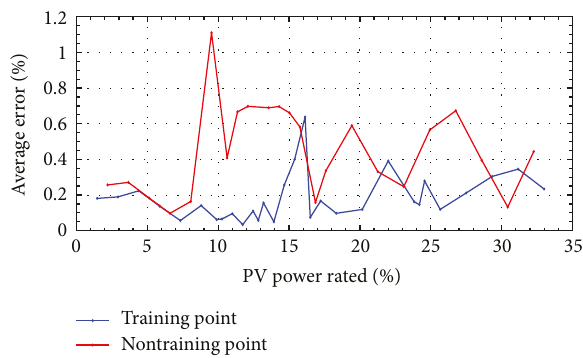
Figure 14: Average error magnitudes of output current components between the real microinverter and the DDM during burst mode at training and nontraining points.